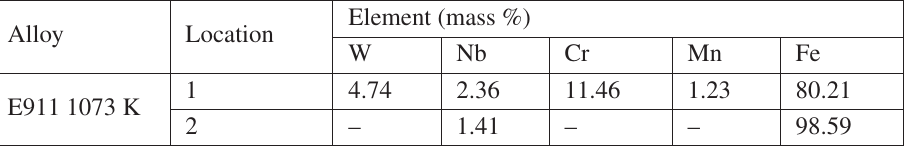
Table 5. EDAX analysis of various points on E911 alloys at 1073 K.